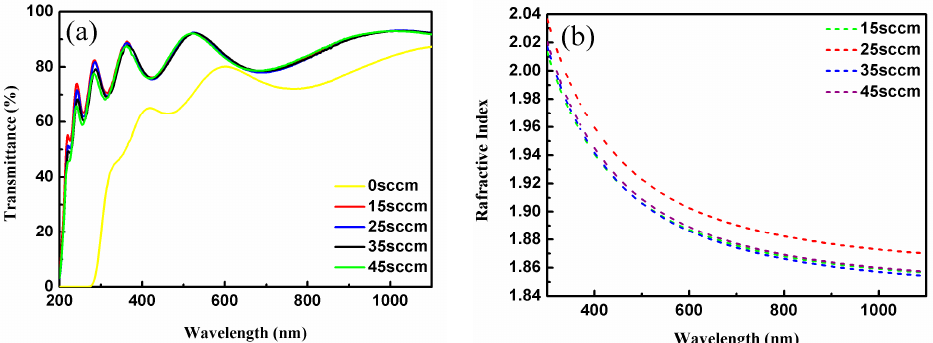
Figure 4. ( a ) Transmittance spectra of Sc 2 O 3 films deposited under different oxygen flow rates; ( b ) Refractive index spectra of Sc 2 O 3 films deposited under different oxygen flow rates. Coatings 2019 , 9 , x FOR PEER REVIEW